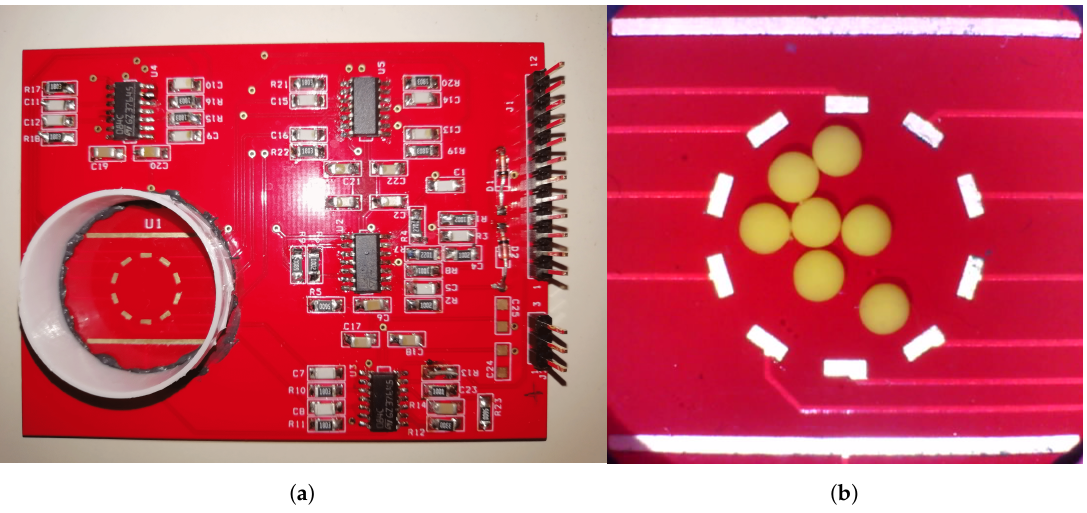
Figure 1. ( a ) overview of the printed circuit board (PCB) with circuitry and sensor (bottom left), and ( b ) zoom of the sensing element with some